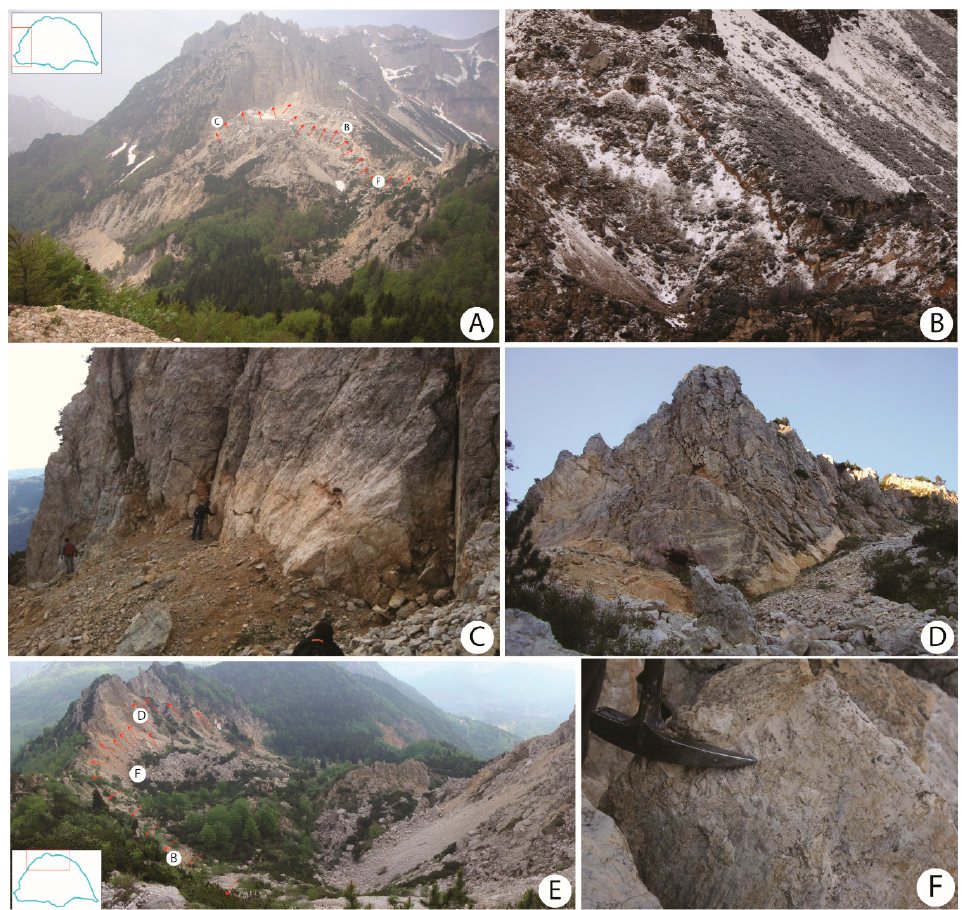
Figure 3. ( A ) View of the western portion of the DSGSD 2010 crown and ( B , C ) details of some areas. Photos ( B ) clearly showing the fresh/newly activated surface near the crown area caused by the 2010 reactivation were taken on 8 November 2010, four days after the debris flow. ( D ) Details of the north portion of the DSGSD 2010 crown. ( E ) Overview of the crown and proximal area. ( F ) Details of ancient smooth surfaces from rubbing in the rupture and sliding crown area and related lineation. Their discovery locations are shown in ( A , E ).